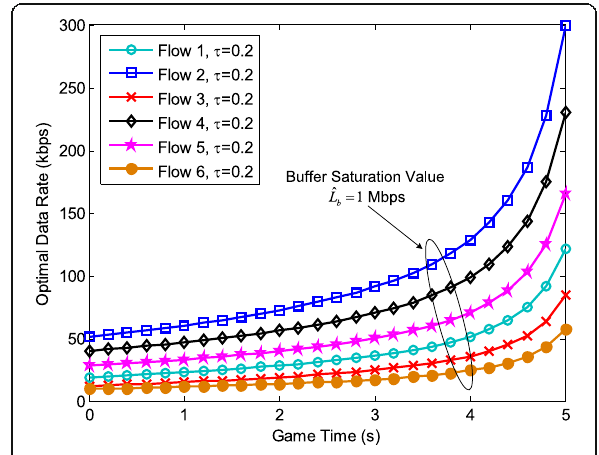
Fig. 10 Optimal data rate comparison among six per-link flows through our proposed ODRU algorithm under saturation value ^ L b ¼ 1